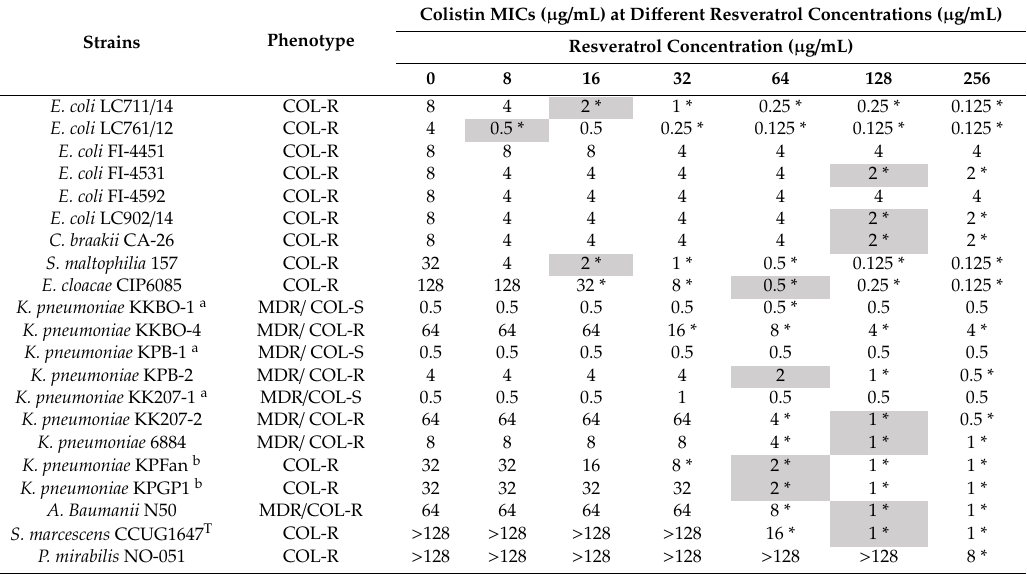
Table 18. Results of checkerboard assays of colistin in combination with resveratrol from Cannatelli et al. (2018)